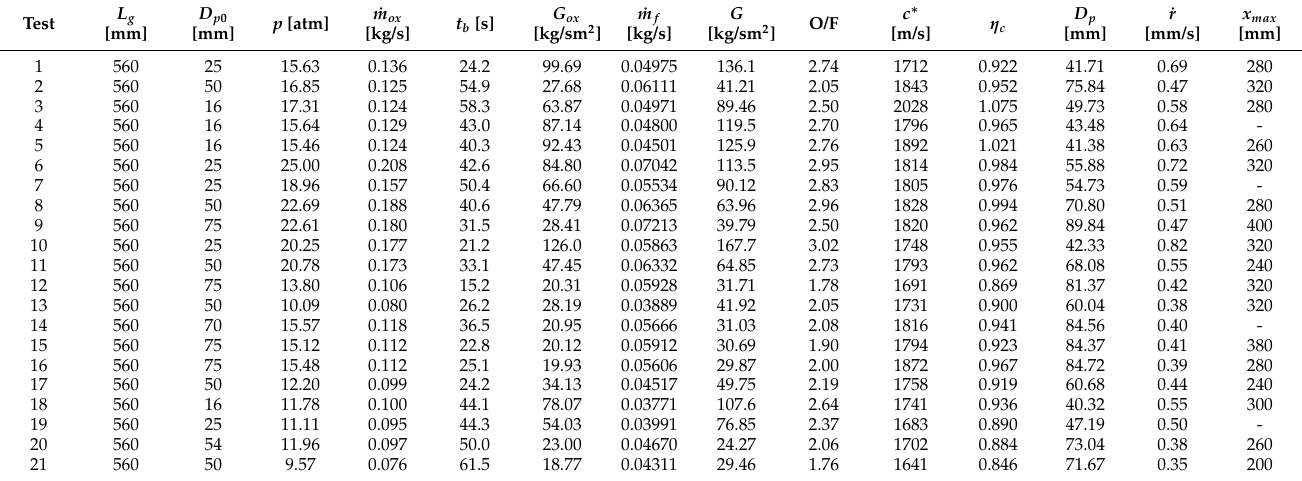
Table 1. Experimental data from literature for a lab-scale GOX-HDPE motor